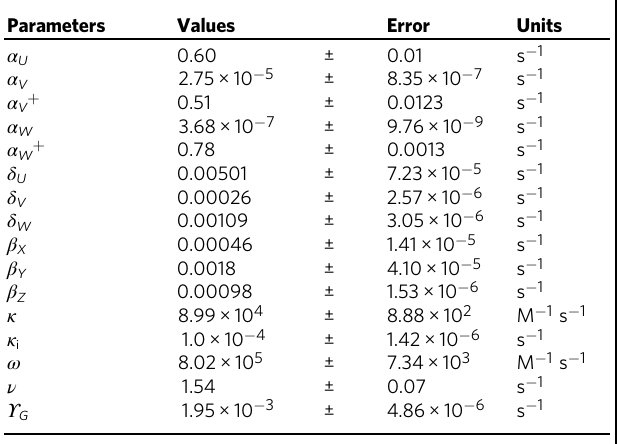
Table 1 Estimated model parameters obtained from the least squares fi tting for the ODE model shown in Fig.